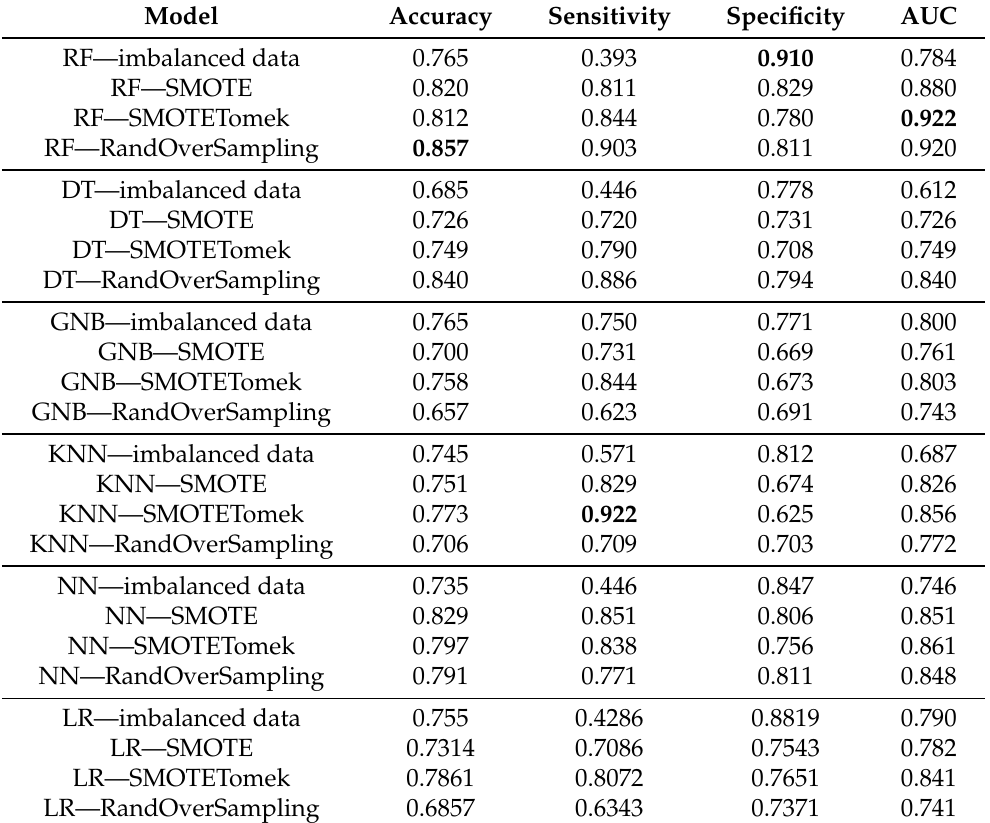
Table 8. L1-based feature selection with different classification algorithms. Values in bold are the maximum of each